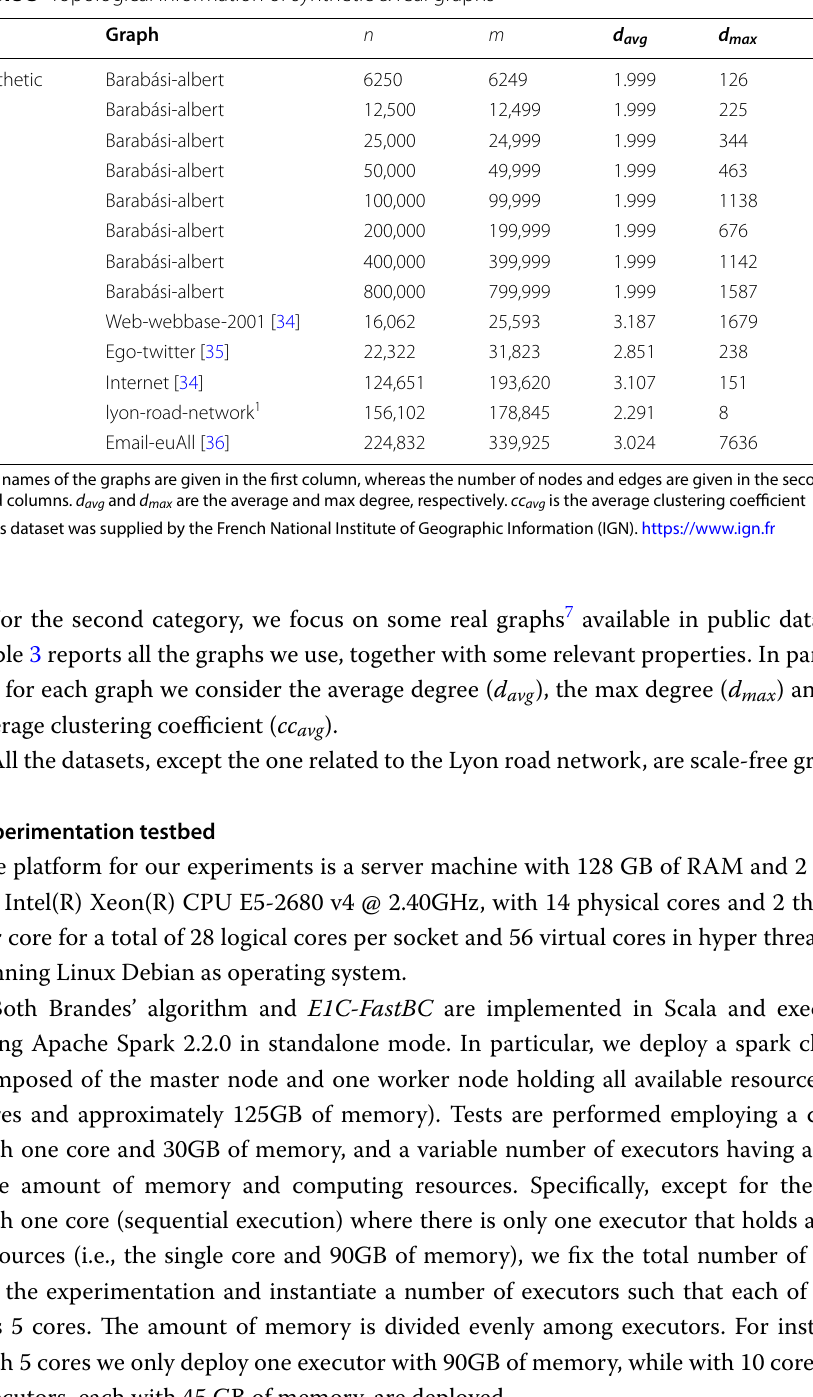
Table 3 Topological information of synthetic & real